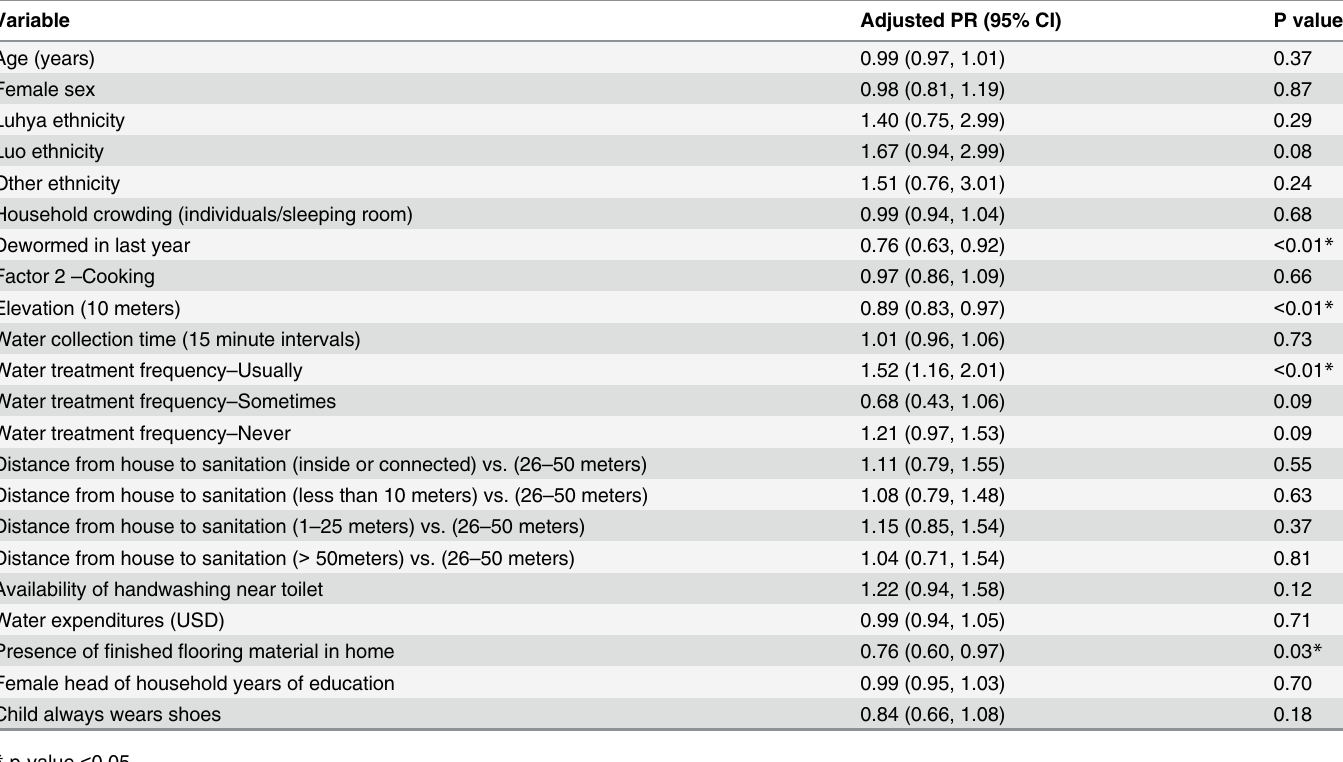
Table 2. Associations for Water, Sanitation, and Hygiene-related Risk Factors with Any Soil-Transmitted Helminth Infection among PSAC and SAC Children in Multivariate